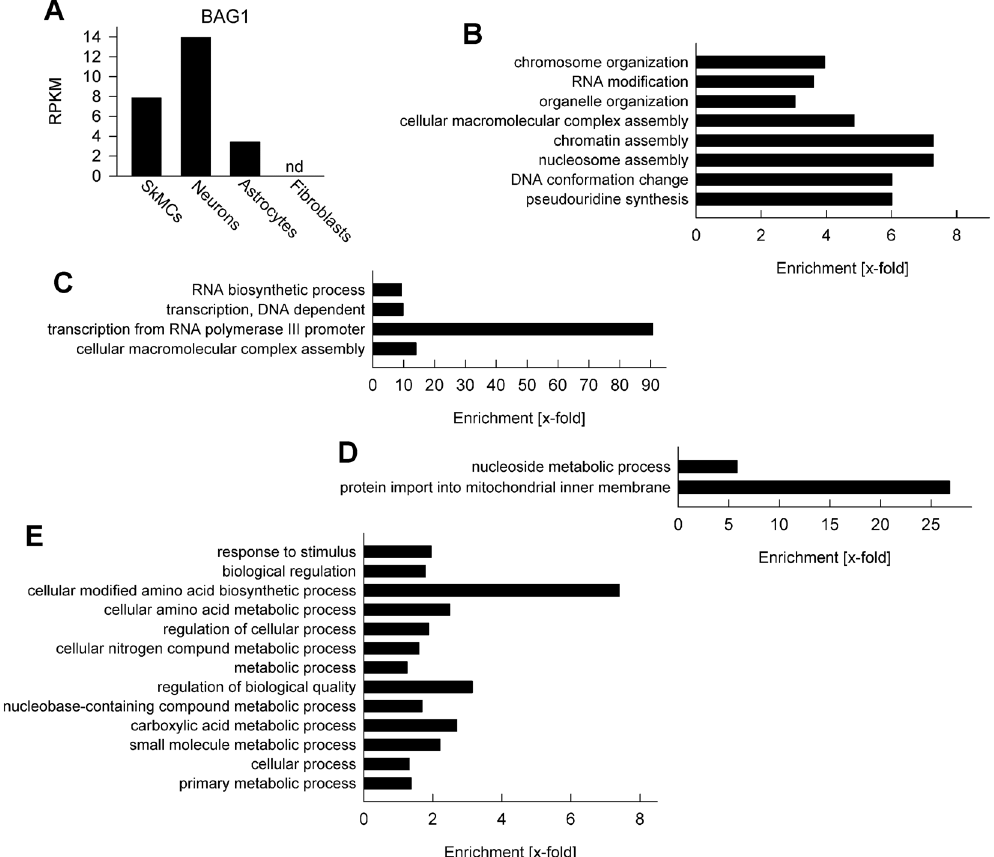
Figure 6. Differential gene expression in T. gondii following infection of either mature SkMCs and neurons or astrocytes and fibroblasts at a MOI of 5:1 for 24 hours. Expression profiles of T. gondii were obtained by high- throughput RNA sequencing and parasite genes were extracted that were differentially expressed depending on the host cell type (Chi 2 FWER < 0.01). ( A ) Expression of bradyzoite antigen (BAG)-1 in T. gondii during infection of host cells as indicated. Data are reads per kilobase per million mapped reads (RPKM). Nd: not detected. ( B – E ) Biological processes showing differential gene expression profiles in T. gondii residing within SkMCs and neurons as compared to those in astrocytes and fibroblasts. Annotation terms that were overrepresented among the genes from cluster 9 ( B ), cluster 10 ( C) , cluster 20 ( D ) and cluster 21 ( E ) indicated in Fig. 5A as compared to the reference genome were identified by using the GO analysis tool at www.toxodb.org (FDR < 0.05 with Benjamini-Hochberg correction for multiple testing). Redundant annotation terms were